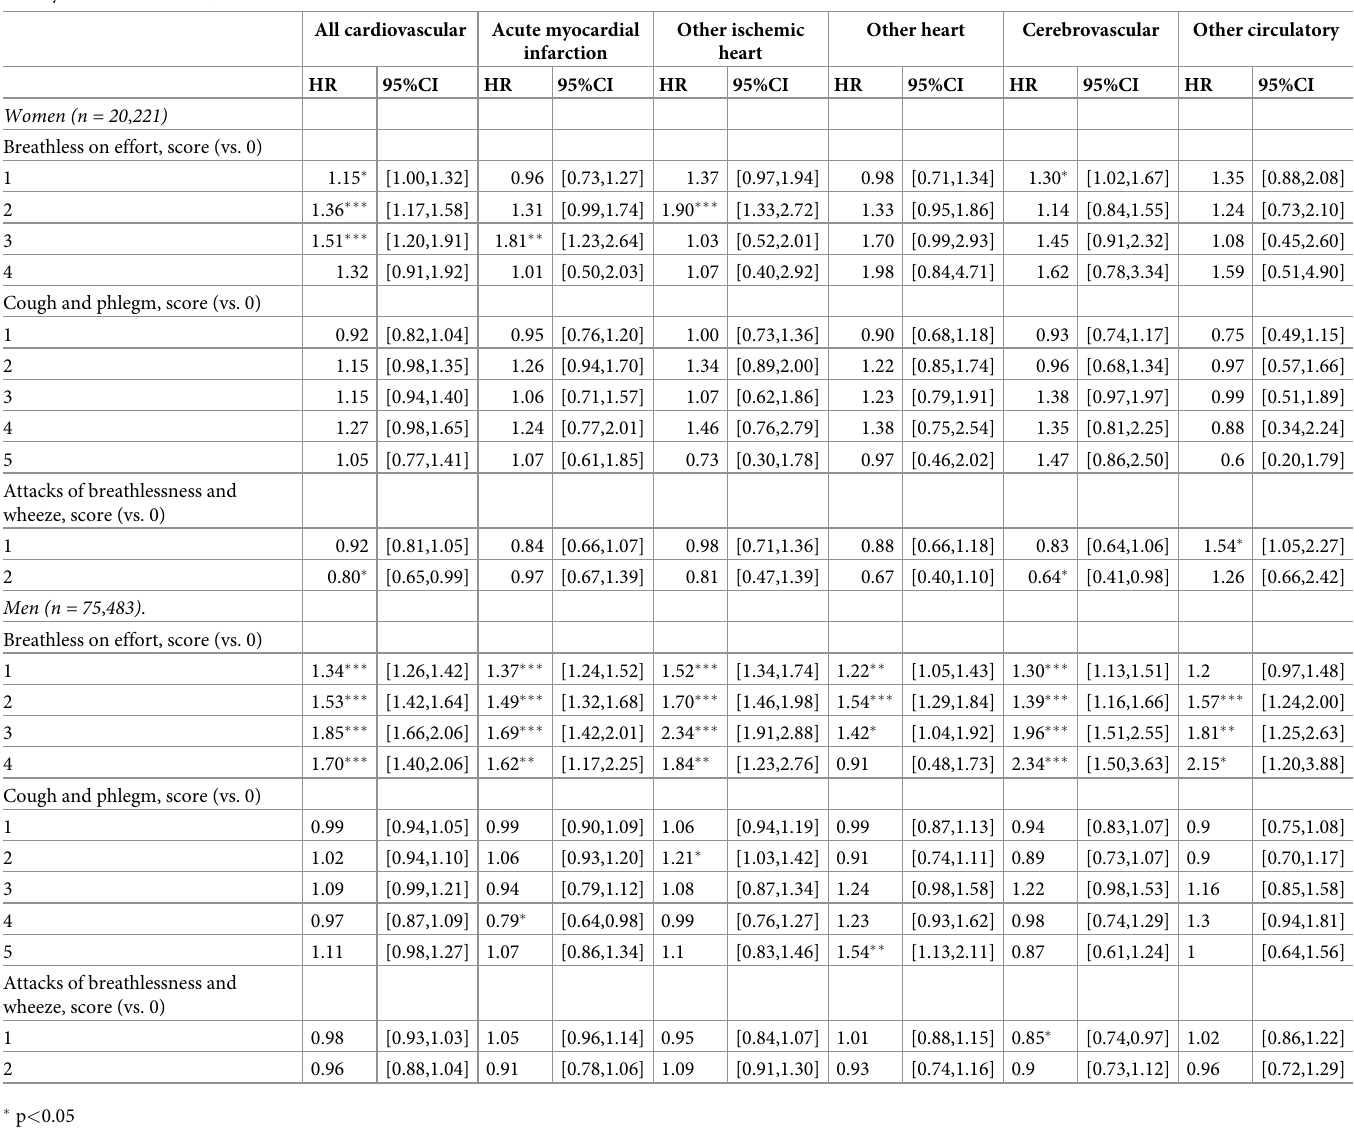
Table 5. Stratified analyses for women and men. Hazard ratios with 95% confidence intervals and p-values according to cause of death, multivariable proportional haz- ards regression analysis with adjustment for education, smoking status, occupational exposure to gas/dust, previous angina pectoris, previous other heart disease and previ- ous myocardial infarction, and birth